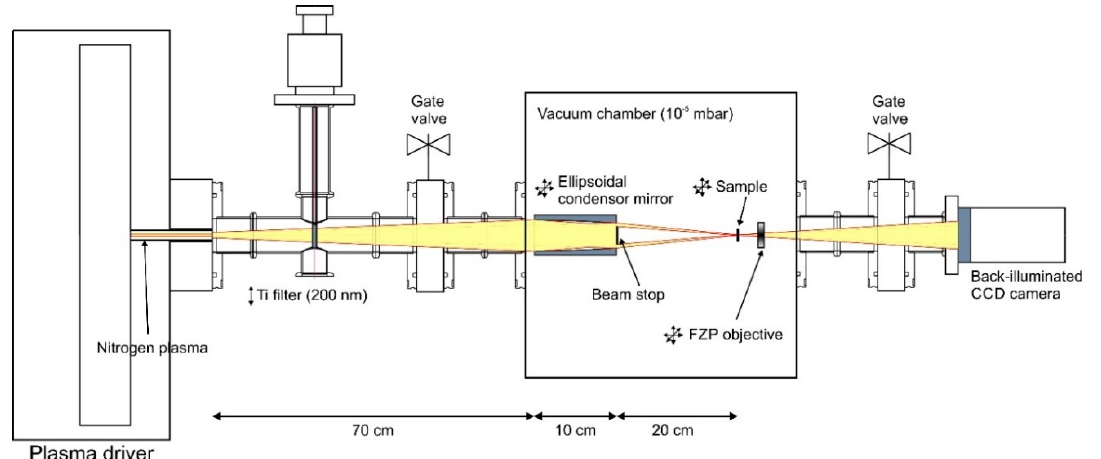
Figure 2. Schematic of a water-window microscope based on a nitrogen plasma capillary discharge source.